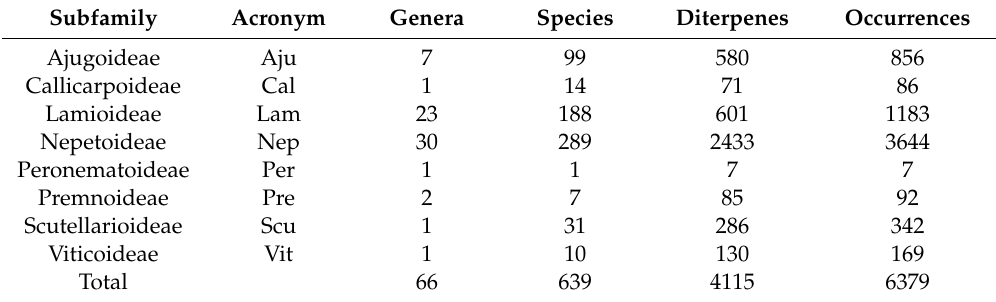
Table 1. Lamiaceae subfamilies listed according to Li et al. [3]. Abbreviations, botanical data, number of diterpenes and chemical occurrences added and used in SistematX (https: // sistematx.ufpb.br).